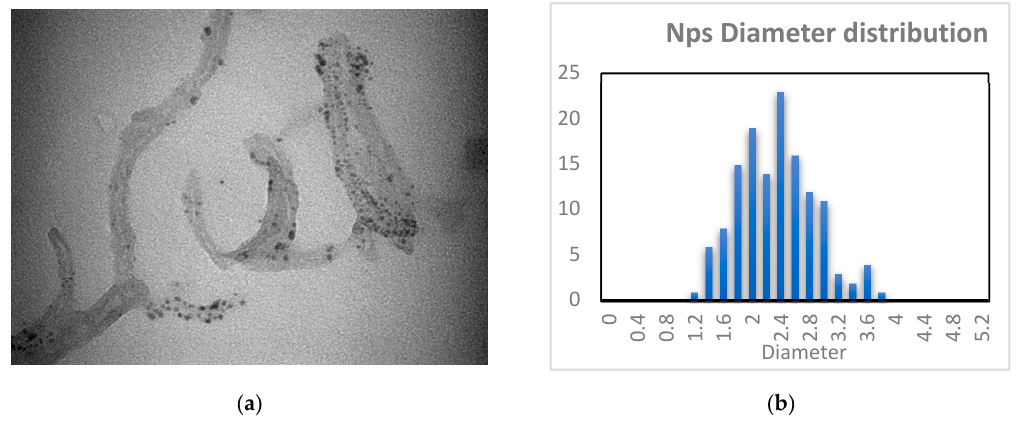
Figure 2. ( a ) Transmission electron microscopy (TEM) image of nanocomposite 20 ; ( b ) Size distribution of Pd(0) nanoparticles (mean value = 2.3 nm, σ = 0.6 nm.